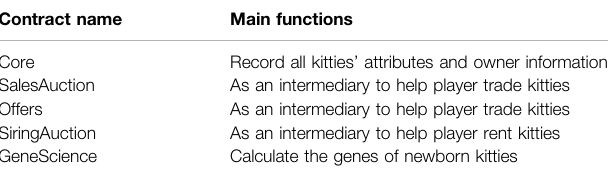
TABLE 1 | CryptoKitties ’ s smart